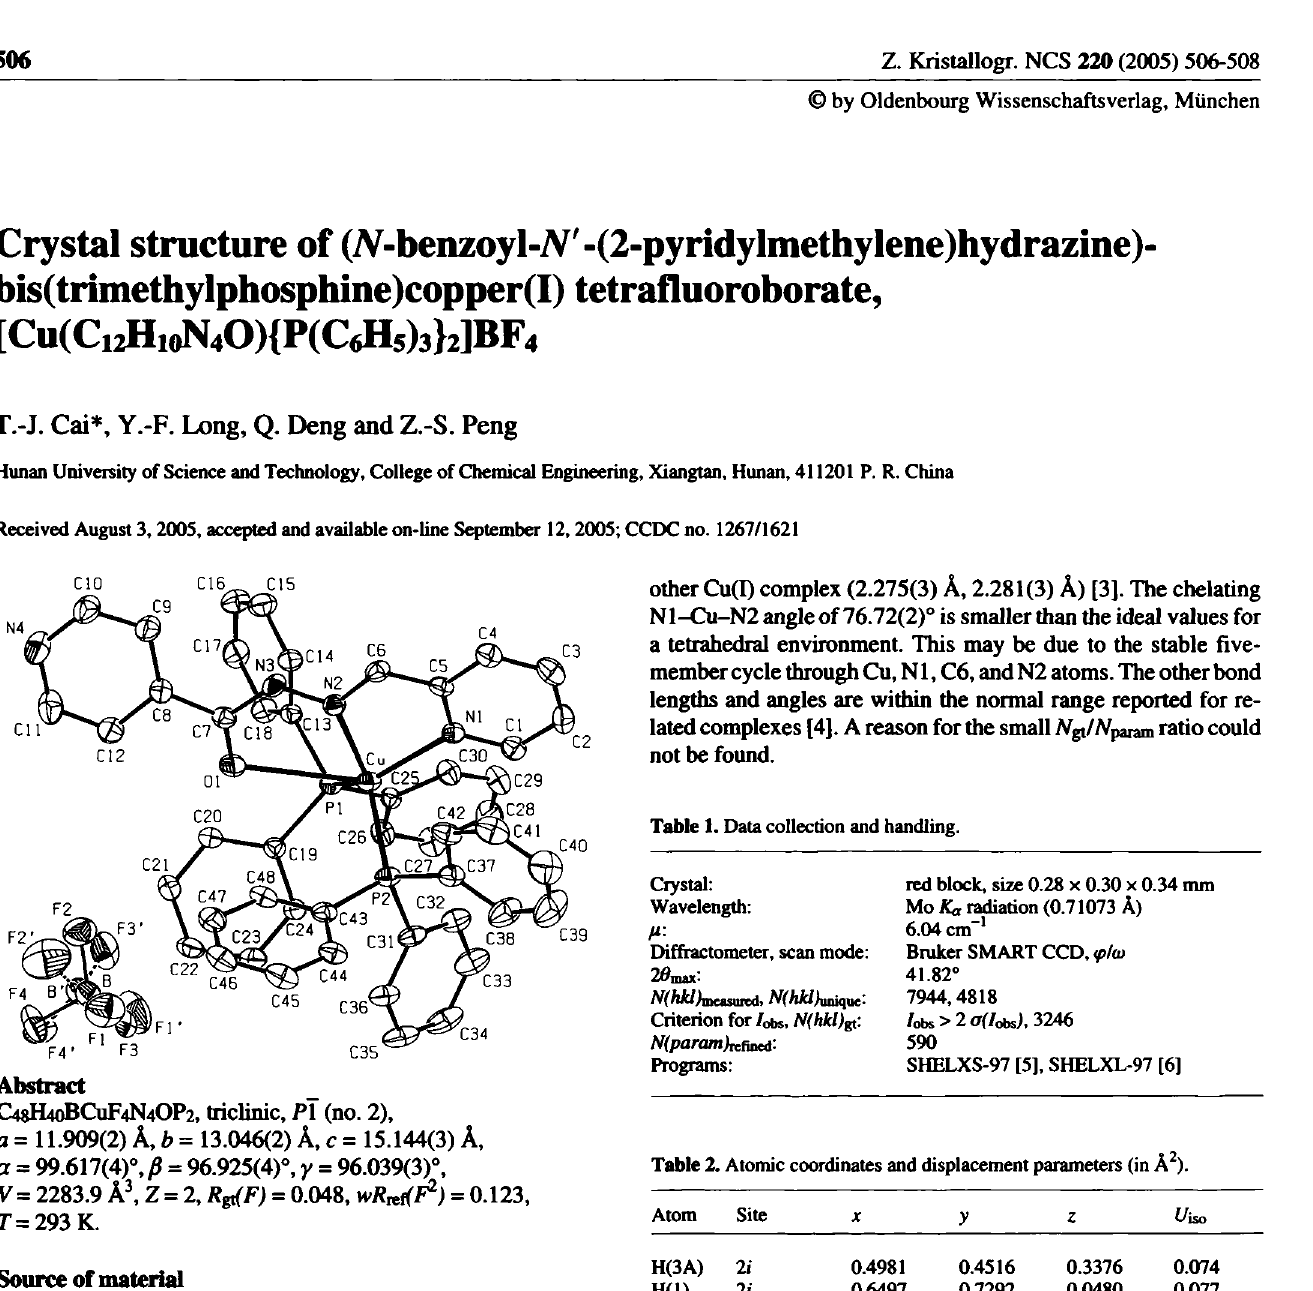
Table 2. Atomic coordinates and displacement parameters (in Ä 2